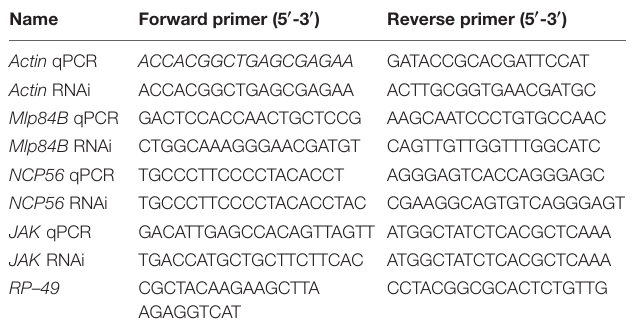
TABLE 1 | Primer sequences for qRT-PCR and RNAi